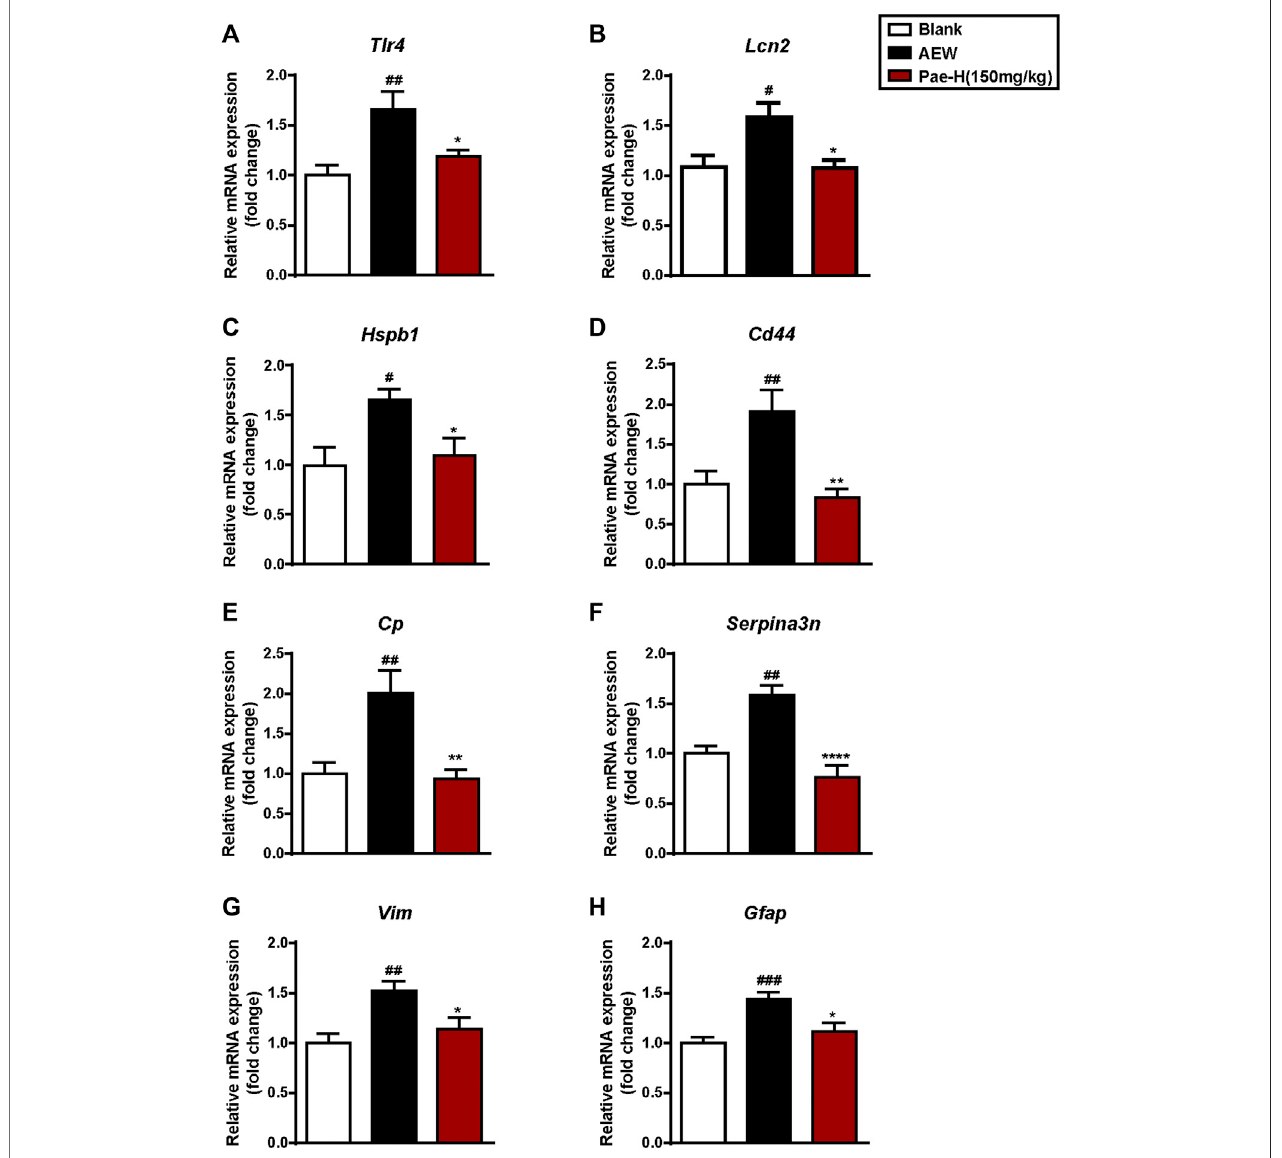
FIGURE 8 | Paeonol suppressed the expression of astrocyte activity-dependent genes in the spinal cord of AEW mice. (A – H) Administration of paeonol inhibited themRNAlevelsofgenesrelatedtoreactiveastrocytes( n (cid:1) 5 – 9eachgroup).Datawereexpressedasmean ± SEM. # p < 0.05, ## p < 0.01, ### p < 0.001,comparedtothe blank group; p p < 0.05, pp p < 0.01, ppp p < 0.001, compared to the AEW model group.